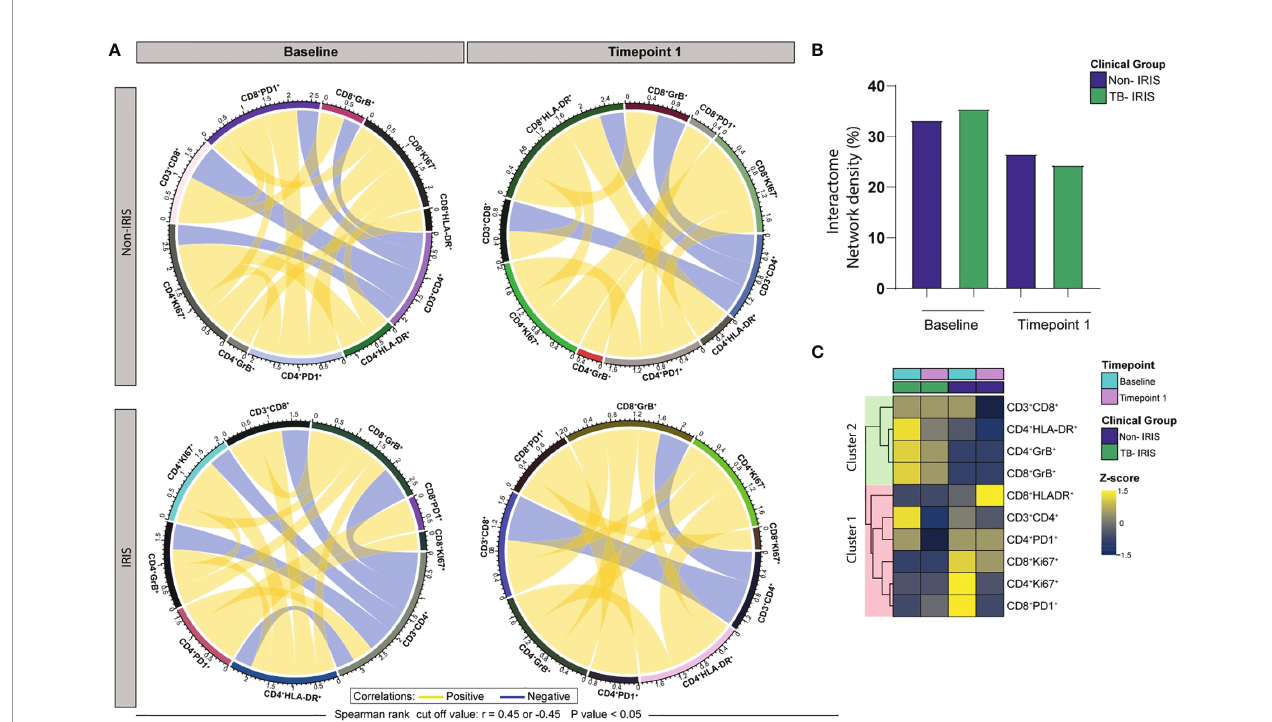
FIGURE 3 | ART initiation and TB-IRIS events are associated with coordinated alterations in the relationship between markers of T lymphocyte activation at Baseline (pre-ART) and 2-6 weeks following ART initiation. (A) Network analysis of T cell populations expressing activation-related markers; correlation matrices were developed with bootstrap (100×). (B) Networks depicting only signi fi cant correlations (p < 0.05), with Spearman rank threshold ± 0.5; graph showing interactome network density among the clinical groups. (C) A heatmap was employed to assess the contribution of each node based on the number of statistically signi fi cant correlations; yellow lines (edges) represent positive correlations between nodes (T cell population expressing activation-related markers), whereas blue lines depict negative